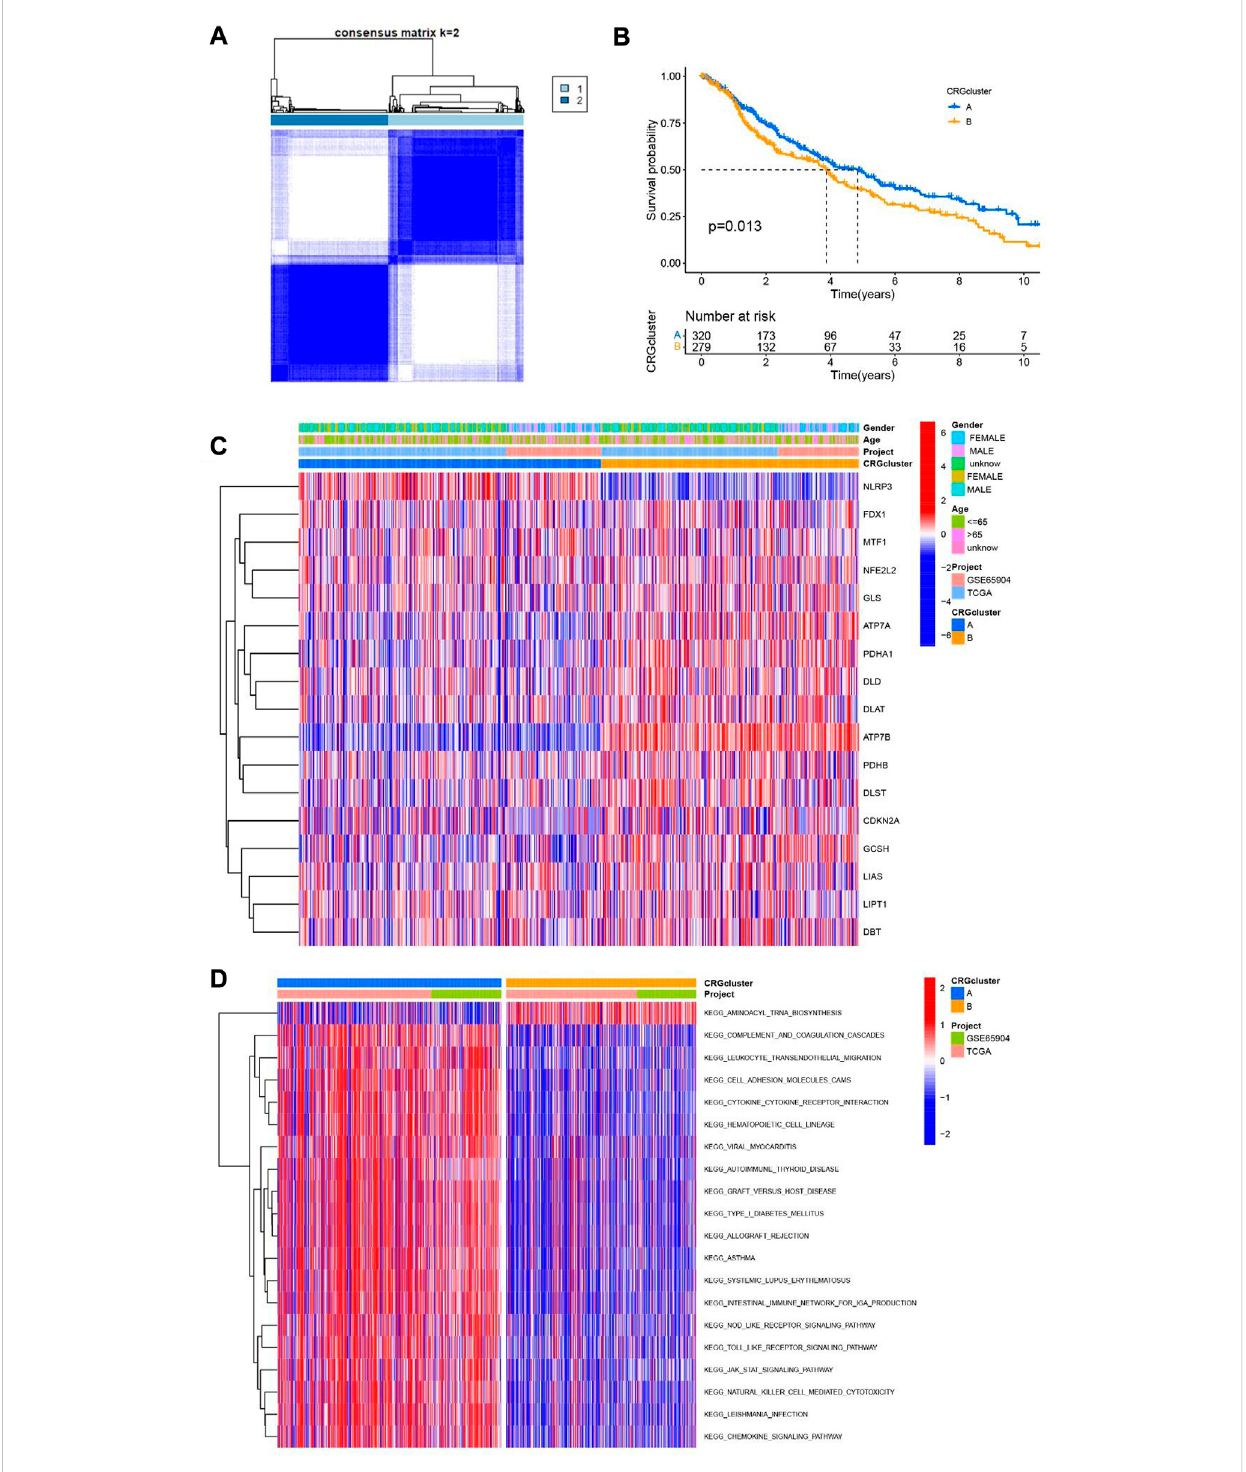
FIGURE 3 Two clusters of cuproptosis-related genes. (A) The Consensus matrix heatmap de fi ned two clusters based on the consistency of cuproptosis- relatedgenesexpression(K=2). (B) Comparethesurvivaltime oftwoclustersthroughKMsurvivalanalysis. (C) Differentexpressionofthetwoclustersof cuproptosis-related genes clusters. (D) KEGG analysis of two clusters of cuproptosis-related